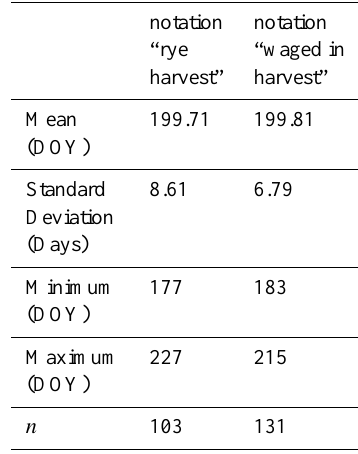
Table 3. Similar statistical properties of two different notations, most probably describing the same agricultural